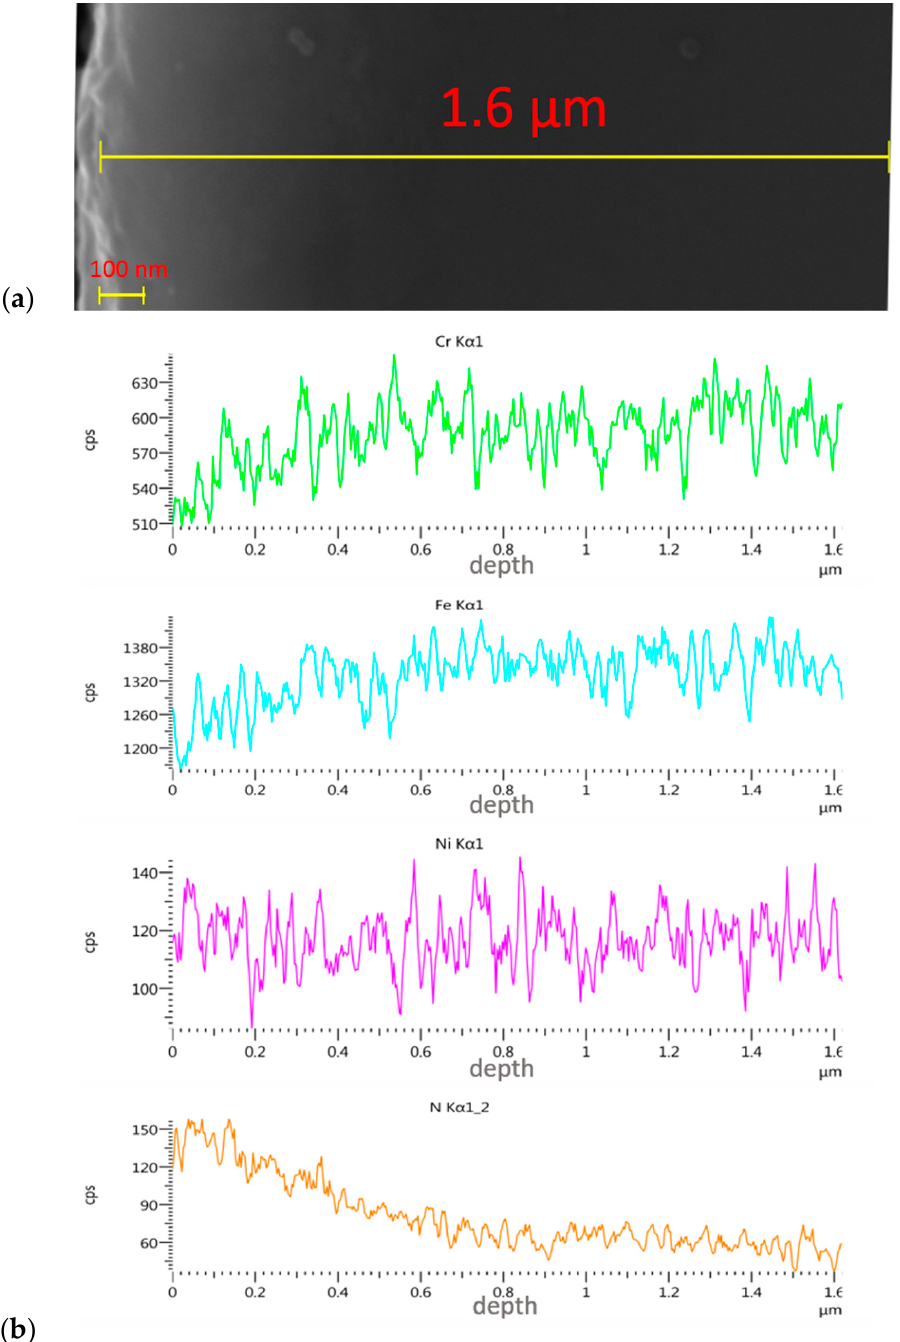
Figure 7. SEM micrograph of the cross-section of steel 316L sample implanted with nitrogen ions ( a ) with linear EDS analysis of elemental distribution ( b ).